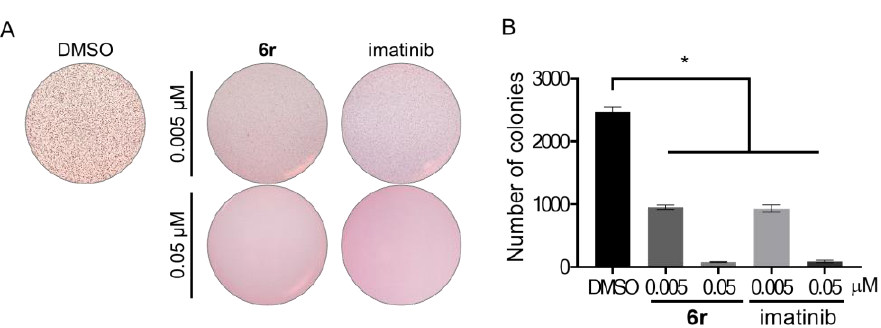
Figure 7. Effects of 6r and imatinib on anchorage-independent growth. ( A ) GIST-T1 cells were cultured in 0.35% agar for 3 weeks. ( B ) The number of colonies was counted using ImageJ. (average ± S.D., n = 3 one-way ANOVA and Tukey’s multiple comparisons test; * p < 0.05)